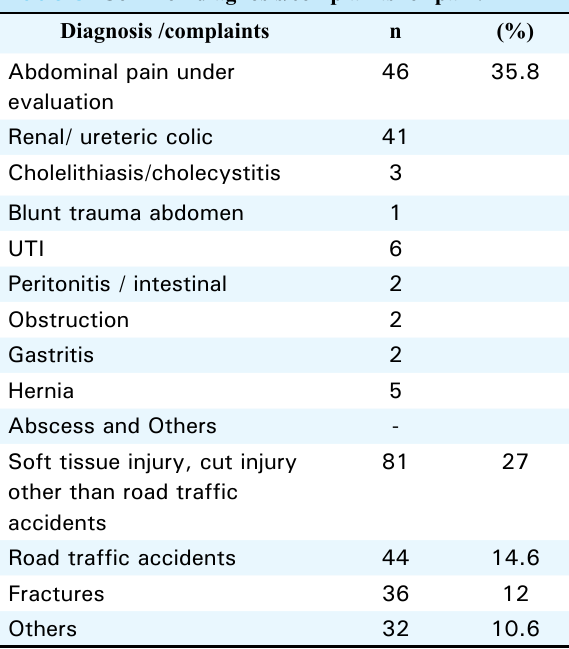
Table 5. Common diagnosis/complaints for pain.